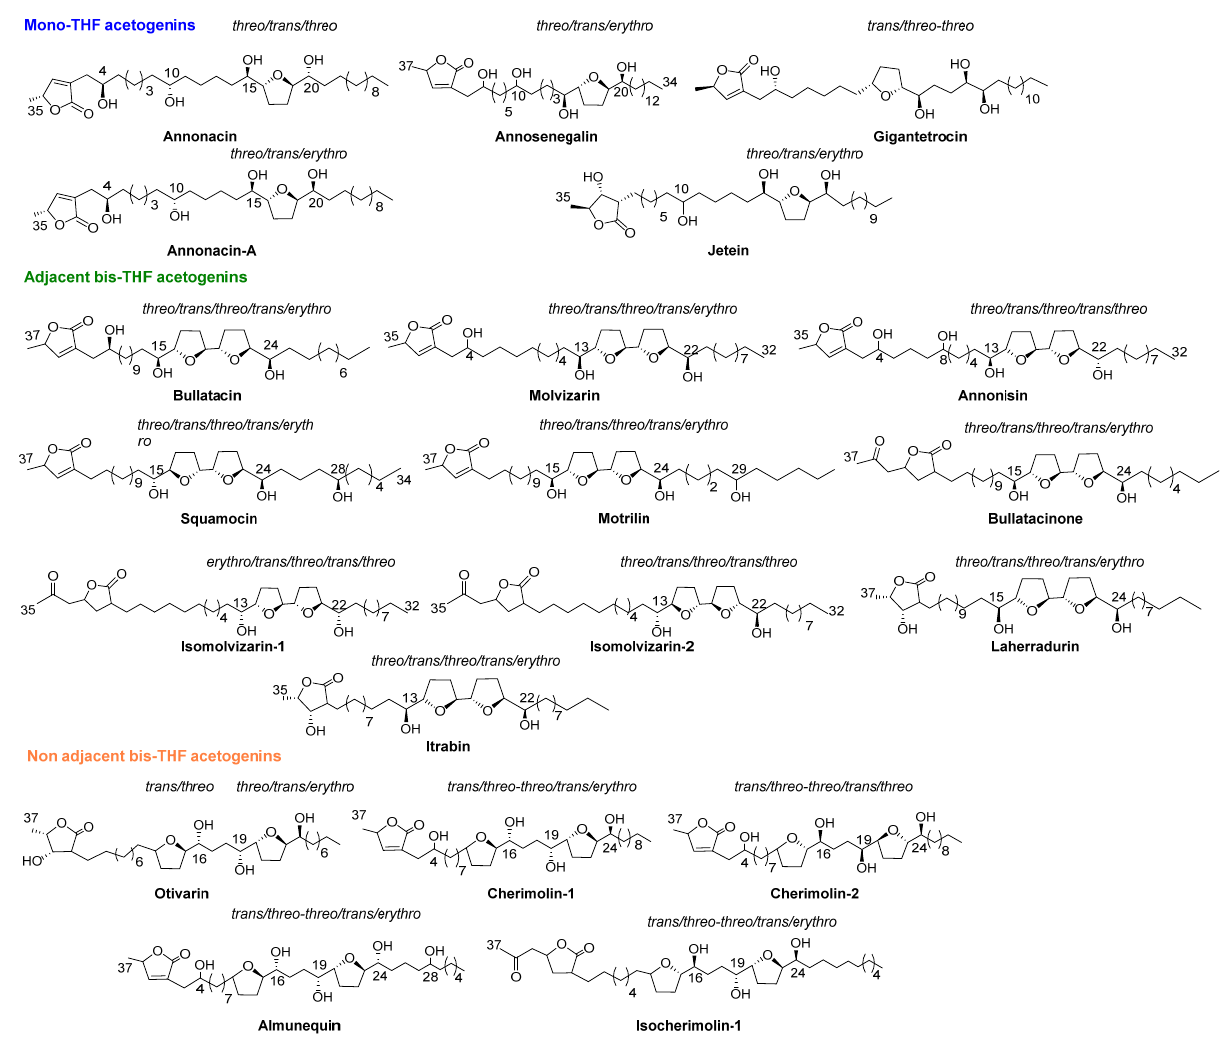
Figure 3. Annonaceous acetogenins isolated from ACMs harvested at ‘Tropical Coast’.